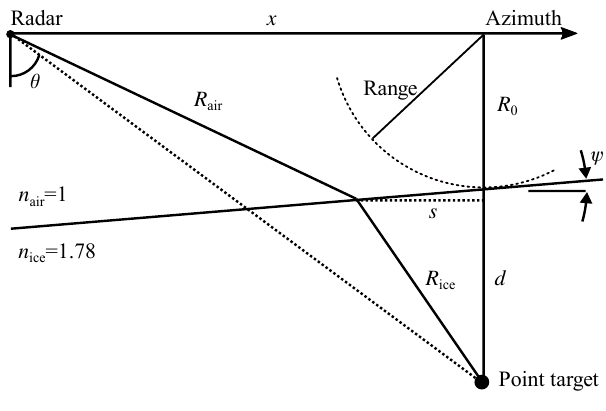
Figure 1. Along-track